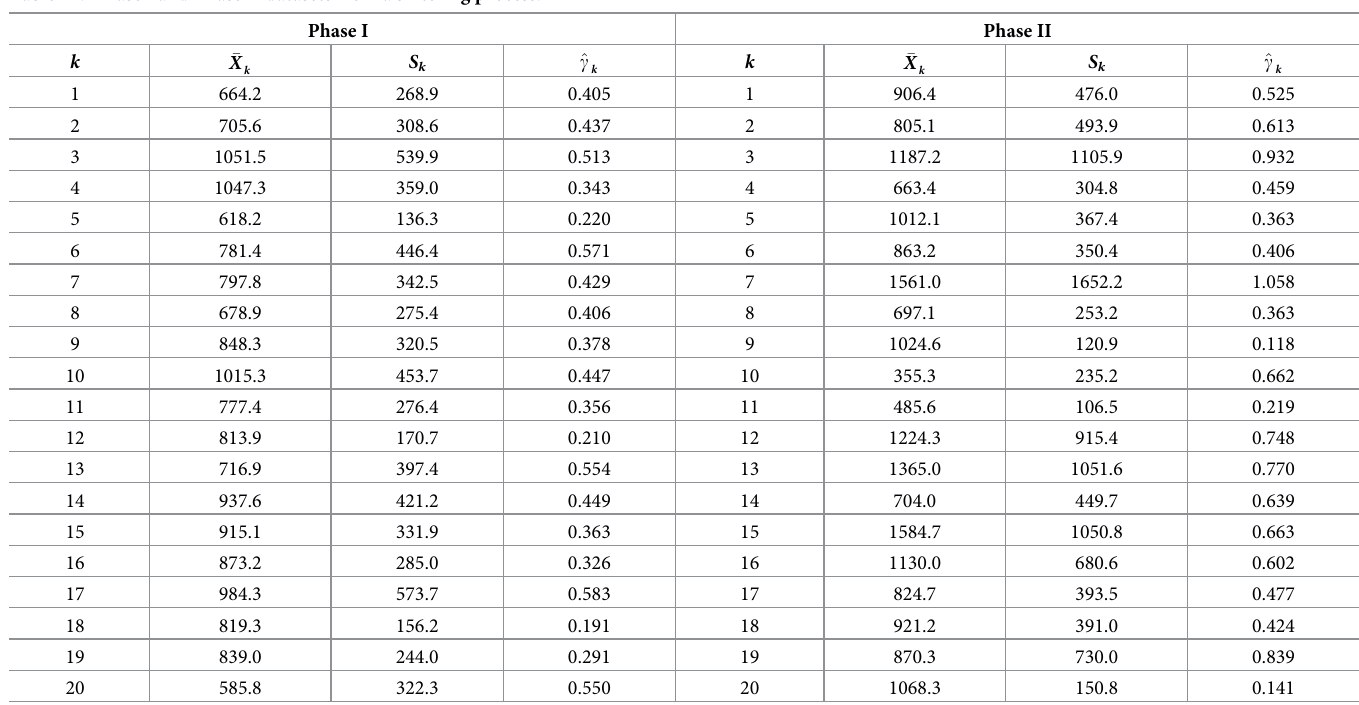
Table 11. Phase I and Phase II datasets from a sintering